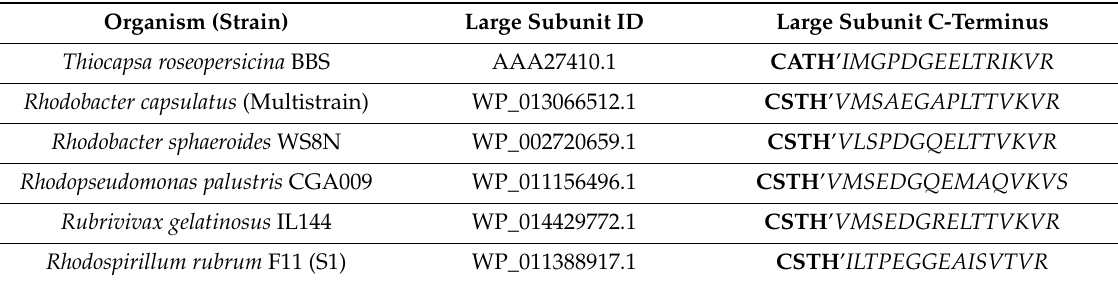
Table A2. Lists of C-terminal sequences of the large subunits of hydrogenases. Four residues comprising the C-end of mature large subunits are shown in bold type; the residues removed by proteolytic cleavage are shown in italic; the sites of proteolysis are marked by single quotation marks.